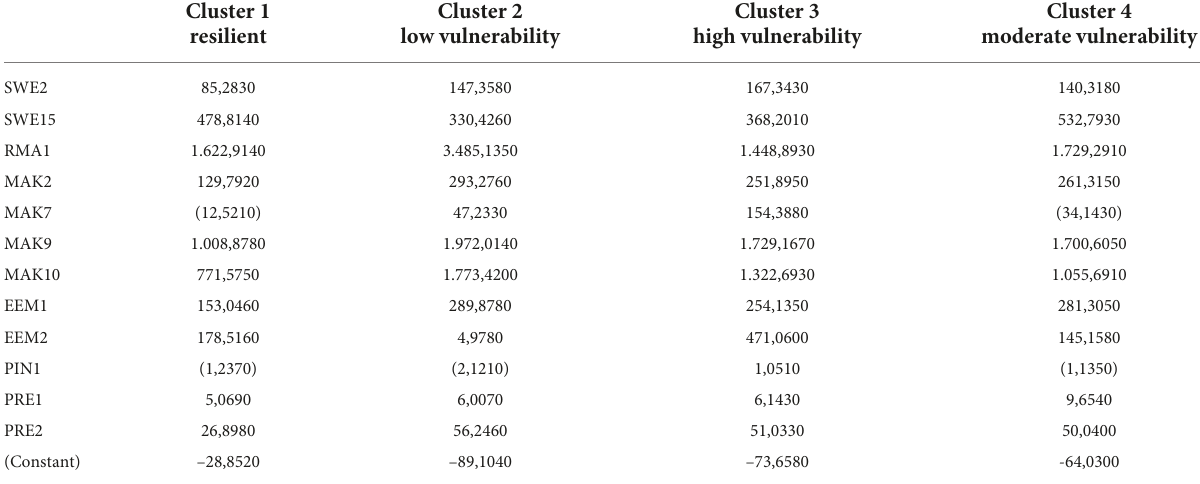
TABLE 6 Fisher’s linear discriminant function